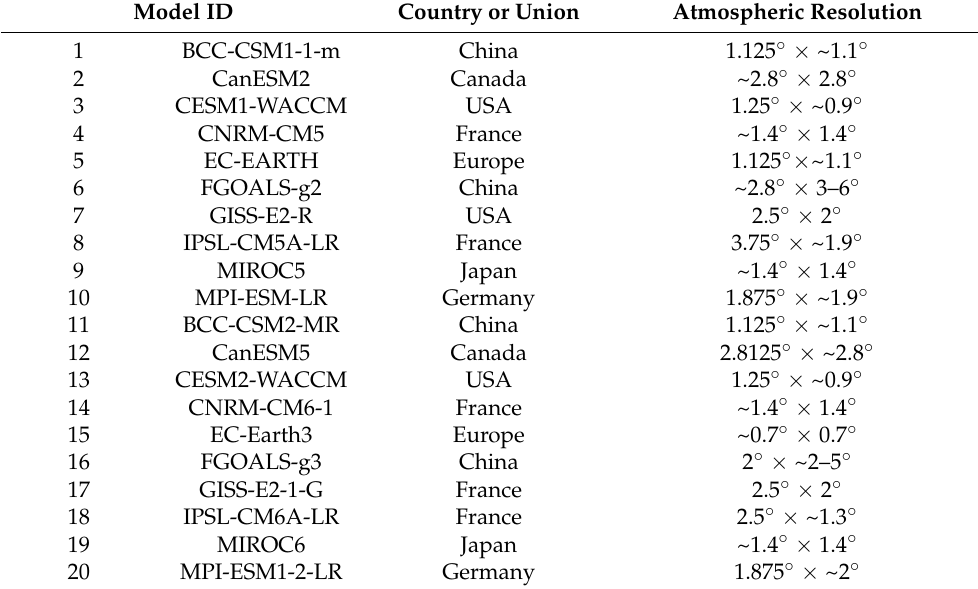
Table 1. Basic information about the 20 GCMs. Model IDs 1–10 are from CMIP5, and IDs 11–20 are from